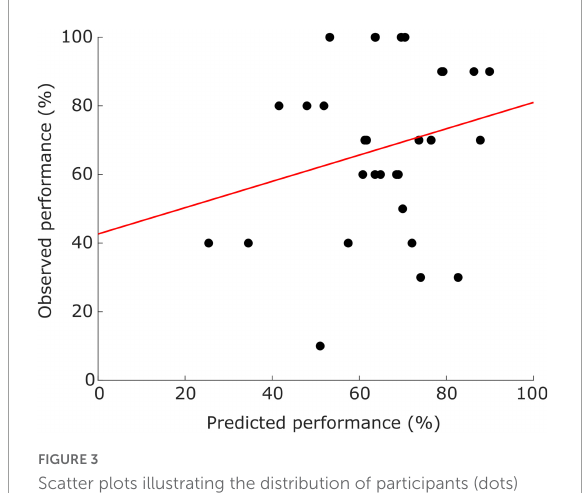
FIGURE3 Scatter plots illustrating the distribution of participants (dots) according to predicted performance ( x -axis) and observed performance ( y -axis). Red line represents the